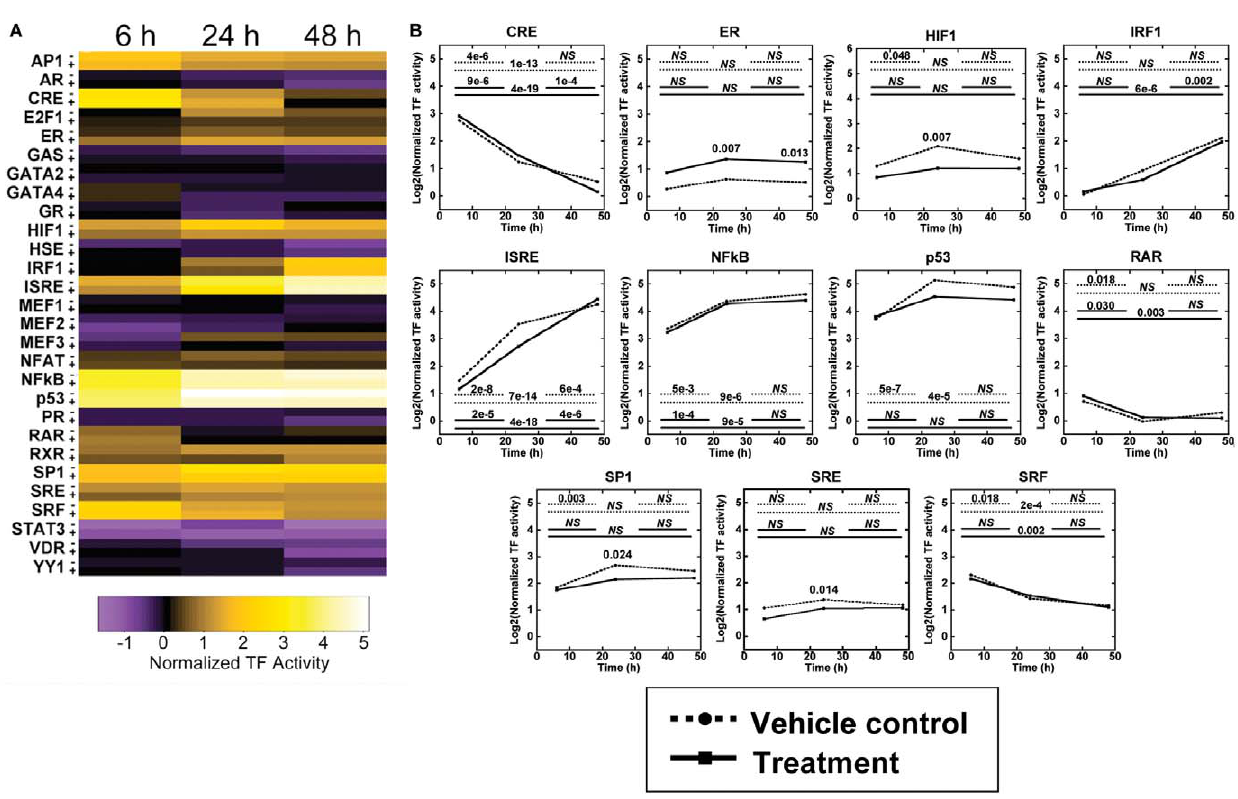
Figure 5. Dynamic large-scale activities of TFs in response to E 2 treatment. (A) TFs had variable activities as functions of treatment and time, as indicated by a heat map representation of log 2 transformation of the means. Vehicle control indicated by ‘ 2 ’ and E 2 treatment indicated by ‘ + ’. (B) TFs that had significant changes with treatment or time are presented on individual temporal plots, with log 2 transformations of the TF activity means plotted. Dashed lines indicate vehicle control and solid lines indicate E 2 treated. Horizontal lines represent comparisons at different time points for each condition, with 6 h to 24 h (top left), 24 h to 48 h (top right) and 6 h to 48 h (bottom). NS indicates no significant difference. A significant difference with E 2 treatment is indicated with the p-value at the significant time point. For example, CRE had significant differences in activity between 6 and 24 h ( P= 4e-6) and between 6 and 48 h ( P =1e-13) for untreated cells, and significant differences for all temporal comparisons for E 2 treated cells. ER had significantly greater activity at 24 and 48 h ( P =0.007, P =0.013), but no significant differences with time. Values are log 2 transformed means from at least three independent experiments carried out in duplicate for each condition.